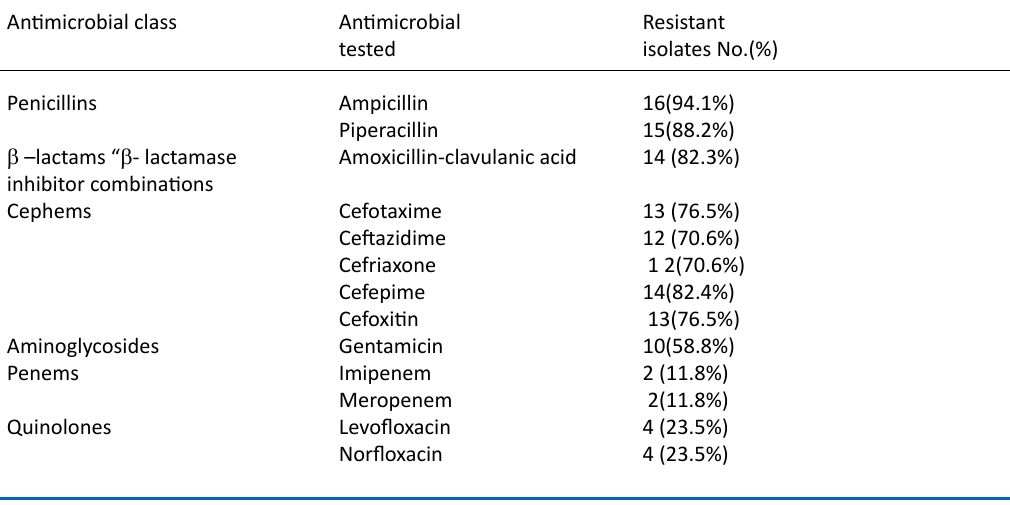
table 2. Resistance profiles of the 17 Klebsiella pneumoniae isolates Antimicrobial